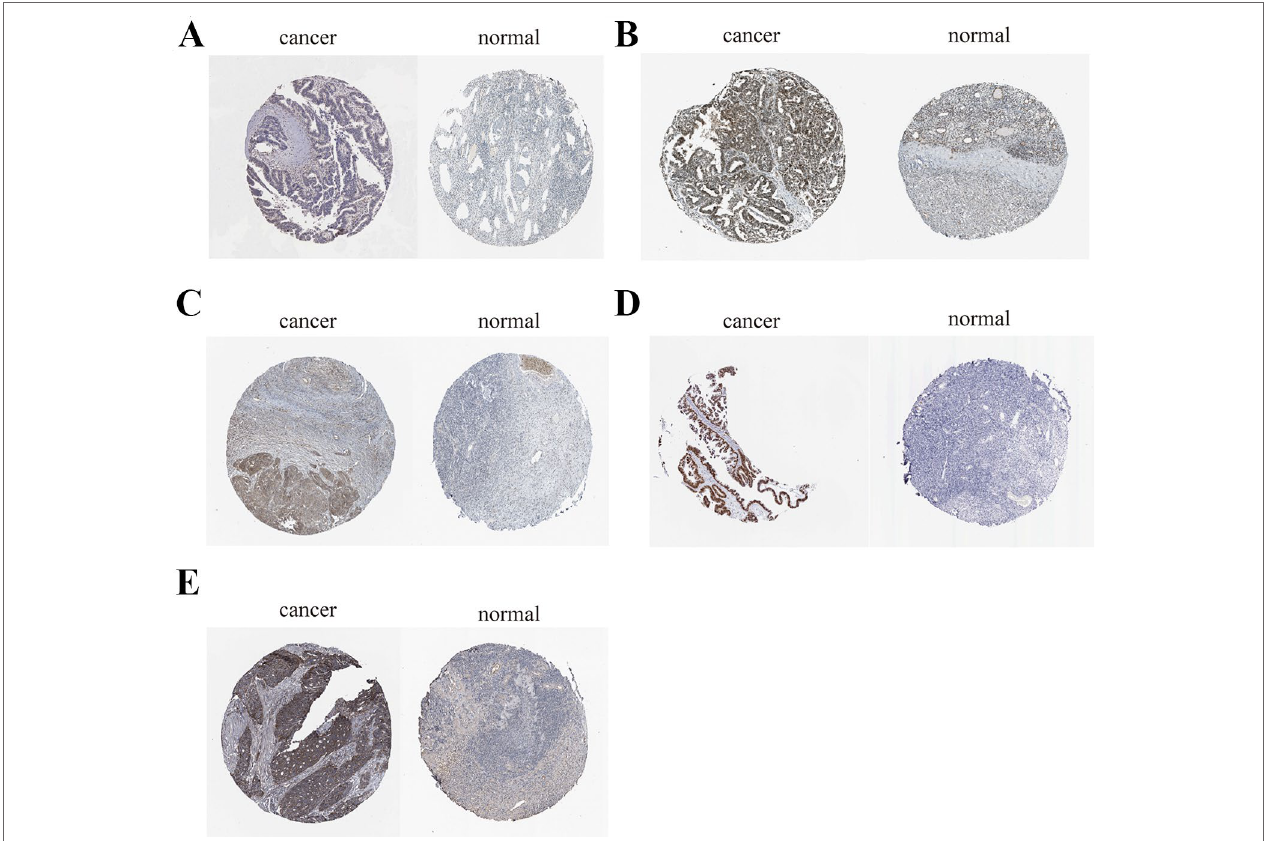
FIgUrE 13 | Immunohistochemistry of the five key genes based on the Human Protein Atlas. (A) Protein levels of CDCA5 in tumor tissue (staining: low; intensity: weak; quantity: > 75%). Protein levels of CDCA5 in normal tissue (staining: not detected; intensity: weak; quantity: < 25%). (B) Protein levels of FOXM1 in tumor tissue (staining: high; intensity: strong; quantity: > 75%). Protein levels of FOXM1 in normal tissue (staining: medium; intensity: moderate; quantity: 75–25%);. (C) Protein levels of KIF15 in tumor tissue (staining: medium; intensity: moderate; quantity: > 75%). Protein levels of KIF15 in normal tissue (staining: not detected; intensity: weak; quantity: < 25%). (D) Protein levels of MCM2 in tumor tissue (staining: high; intensity: strong; quantity: > 75%). Protein levels of MCM2 in normal tissue (staining: medium; intensity: moderate; quantity: 75–25%). (E) Protein levels of ZWINT in tumor tissue (staining: high; intensity: strong; quantity: > 75%). Protein levels of ZWINT in normal tissue (staining: low; intensity: weak; quantity: > 75%).